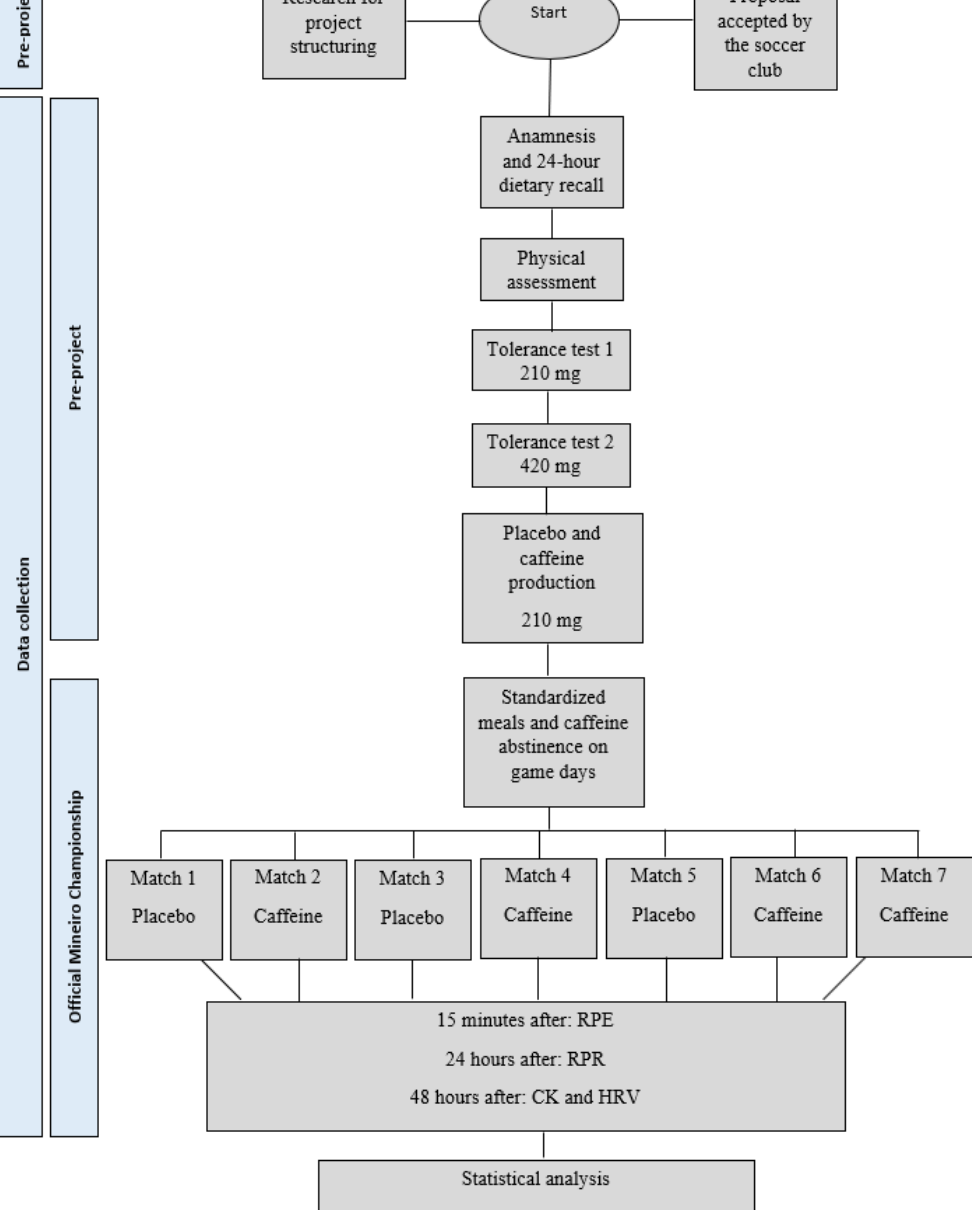
Figure 6. A flowchart containing the stages of the research.